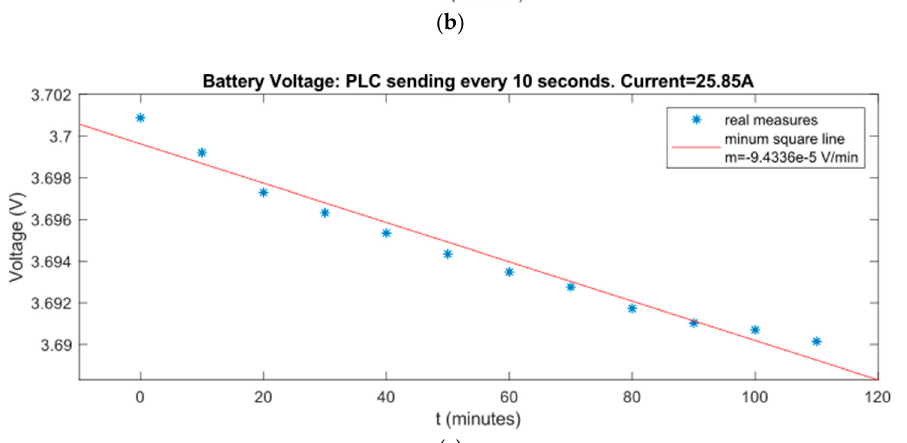
Table 3. Node consumption while not harvesting energy.